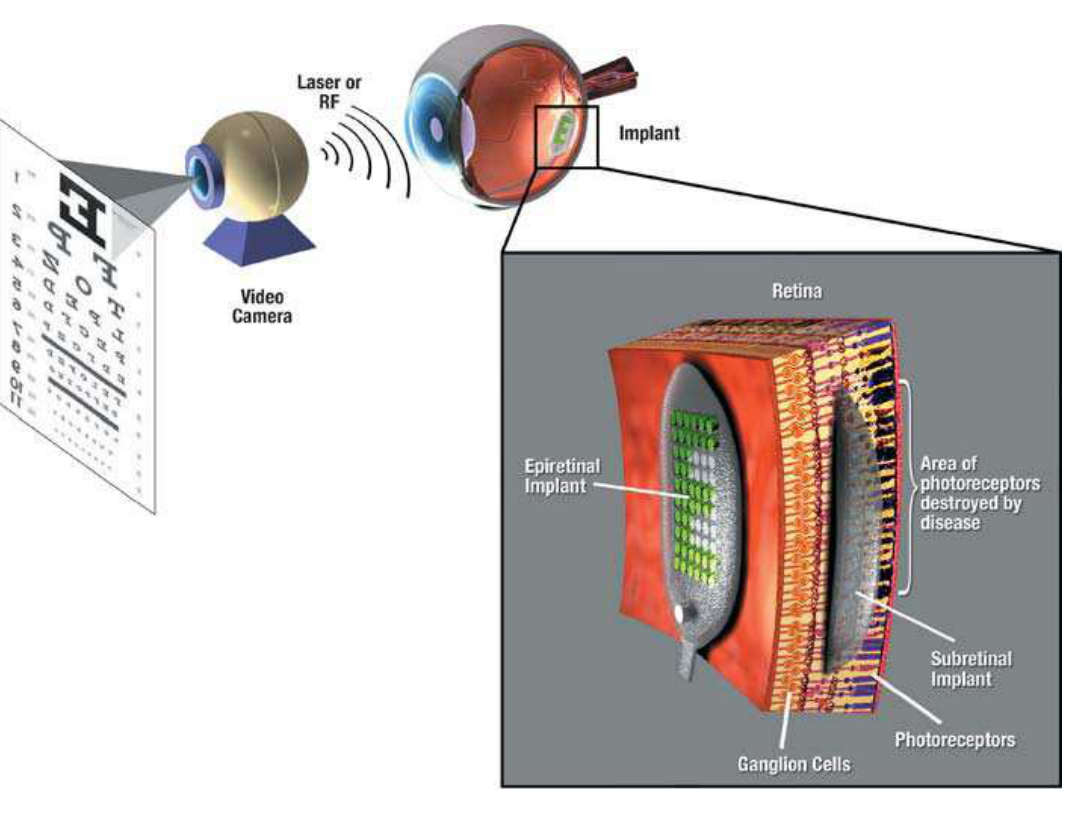
Figure 9 . Schematic of the retinal implant for epiretinal and subretinal prosthesis